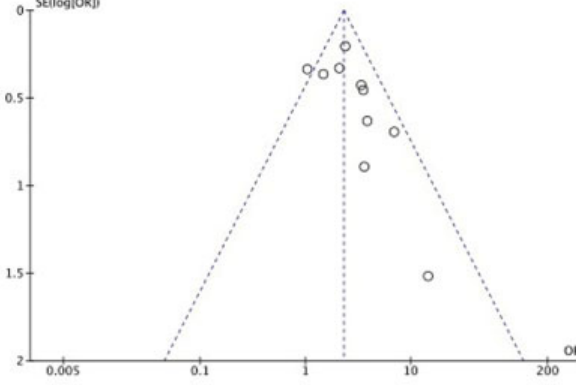
Fig. 3 Funnel plot of the included studies in which abnormal Lp(a) was de fi ned by values above a prespeci fi ed upper normal